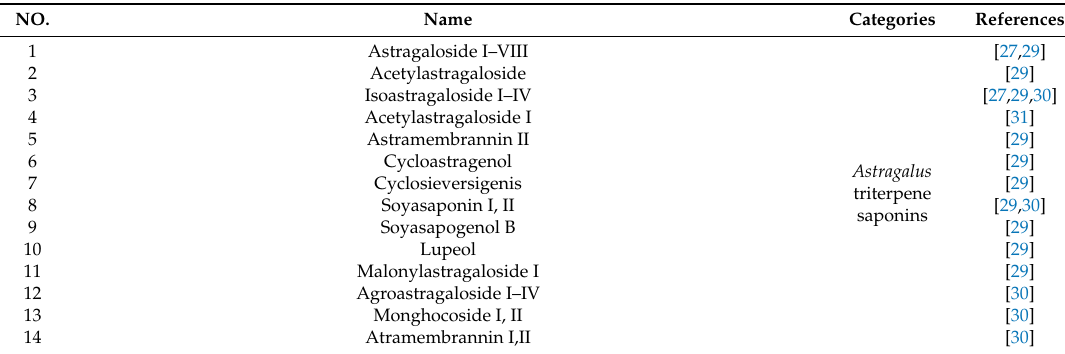
Table 1. The main parts of compounds isolated from